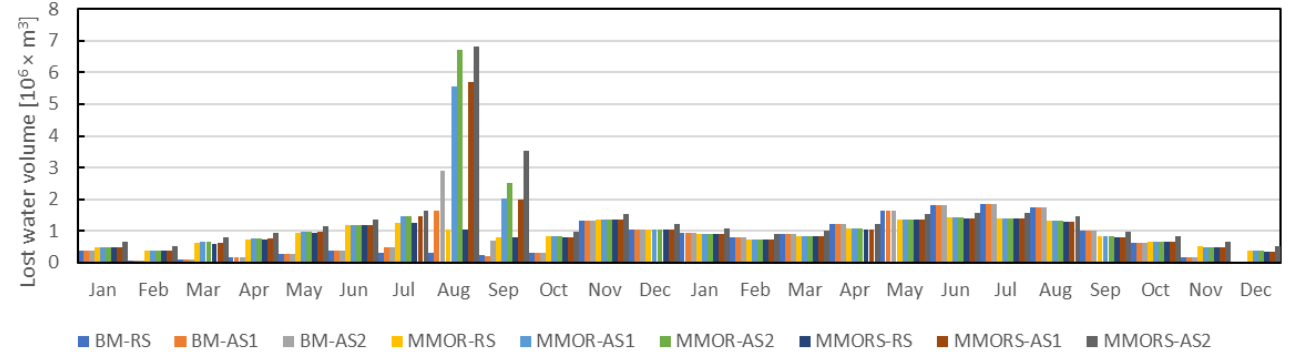
Figure 9. Water volume loss per month for each model variant and input scenario.